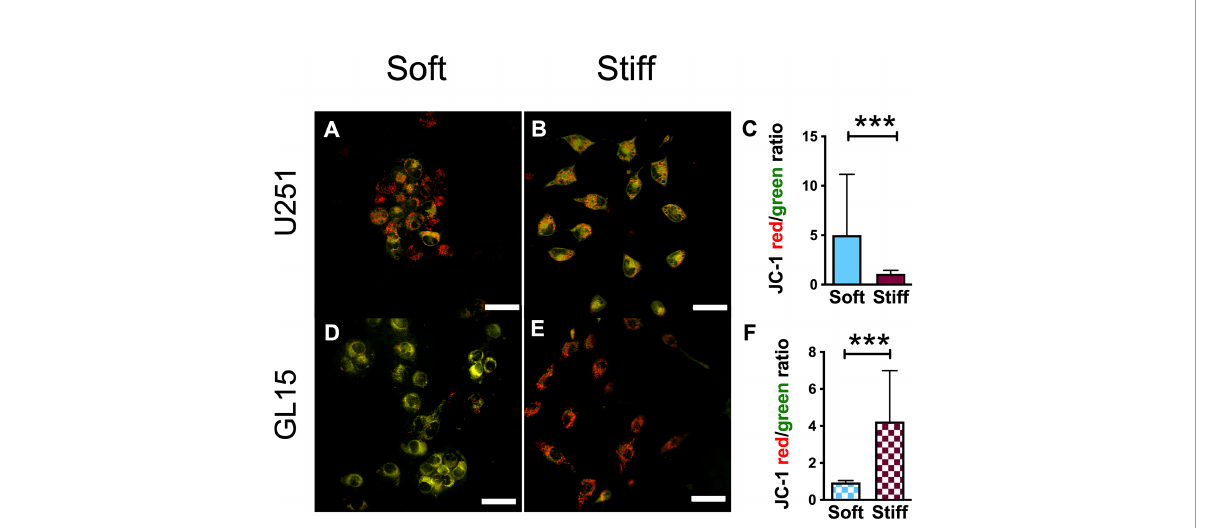
FIGURE 7 Mitochondrial membrane potential is rigidity- and cell type-dependent. (A, B) Representative confocal images showing JC-1 signals in U251-MG cells on Soft (A) and Stiff (B) substrates. The orange/yellow color denotes co-localization of red and green fl uorescence signals. Scale bar 50 m m. (C) Quantitative analysis of DY m, quanti fi ed as the ratio of red/green fl uorescence intensity, in U251-MG cells seeded on the different substrates. (D, E) . Representative confocal images showing JC-1 signals in GL15 cells on Soft (D) and Stiff (E) substrates. Scale bar 50 m m. (F) Quanti fi cation of DY m in GL15 cells seeded on the different substrates. Data presented as mean ± S.D.; n = 3 independent experiments for each condition. Student ’ s t-test;